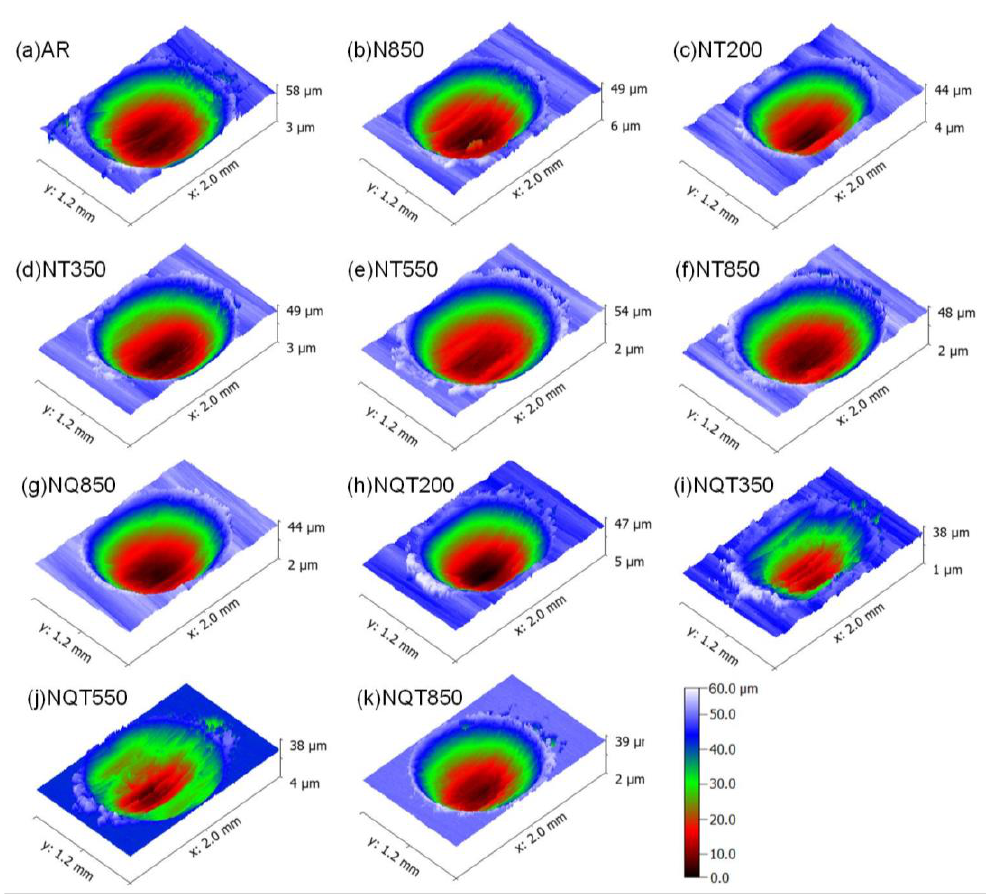
Figure 6. 3D morphologies of worn surface under different tempering states: ( a ) AR state, ( b ) N850, ( c ) NT200, ( d ) NT350, ( e ) NT550, ( f ) NT850, ( g ) NQ850, ( h ) NQT200, ( i ) NQT350, ( j ) NQT550 and ( k ) NQT850 states.